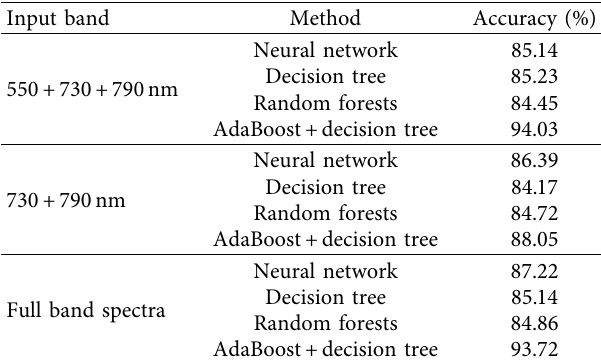
Table 6: Accuracy of cotton topping prediction based on regression